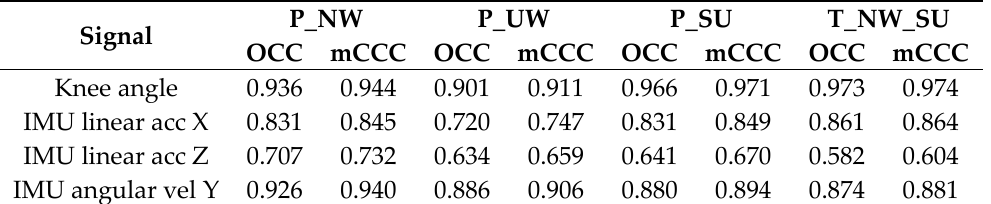
Table 2. Overall correlation coefficient (OCC) and mean class correlation coefficient (mCCC) values of representative gait